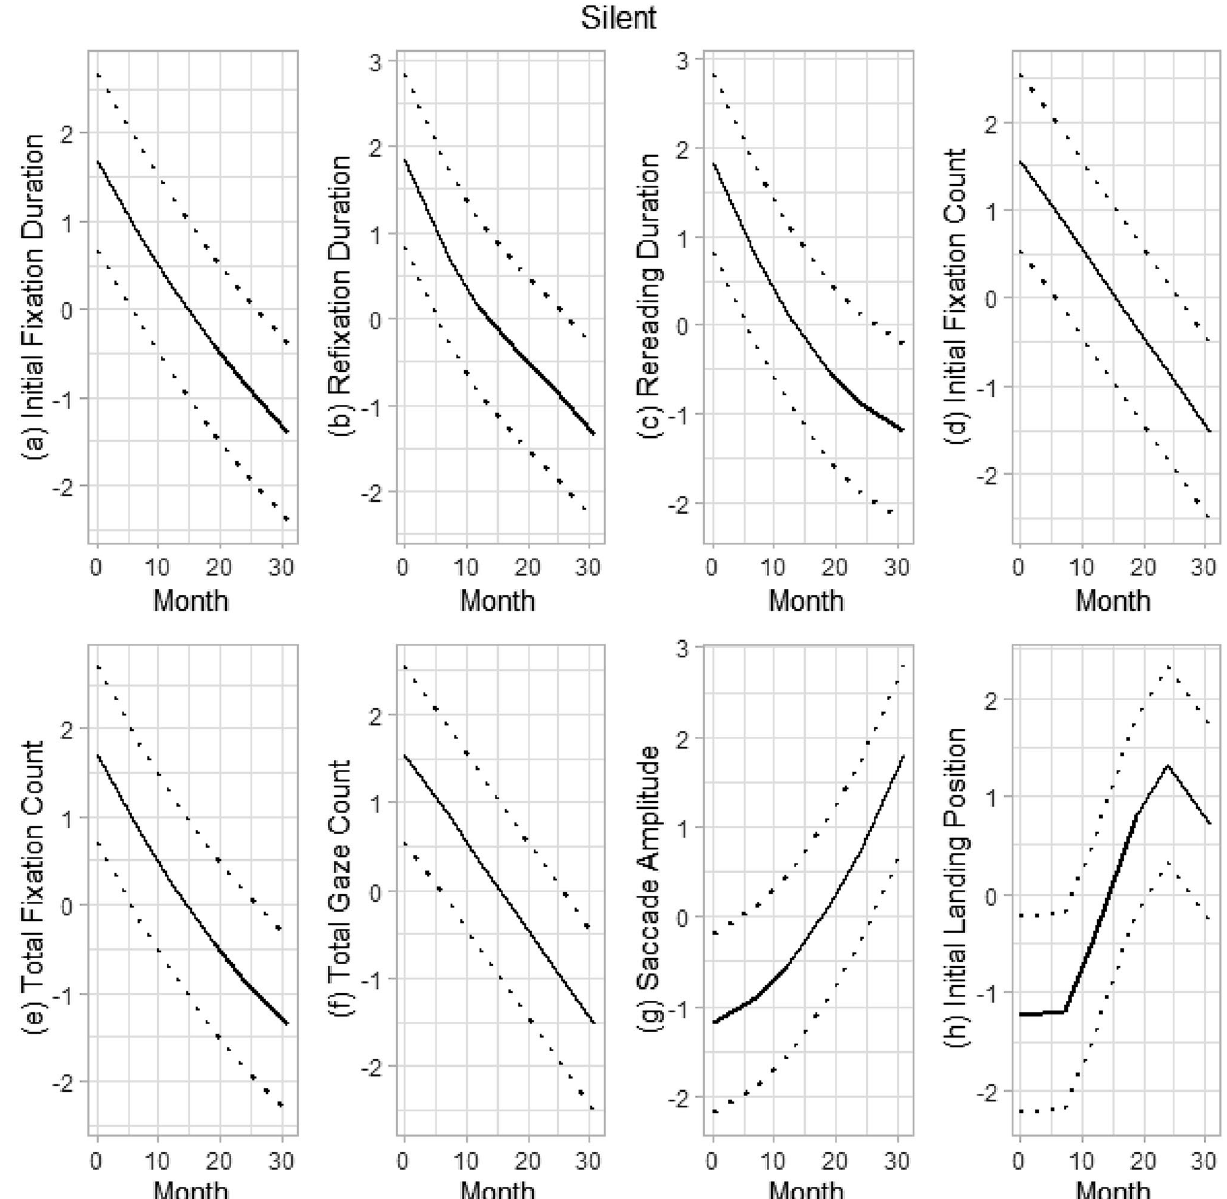
Figure 2. Growth trajectories of eye movements in silent